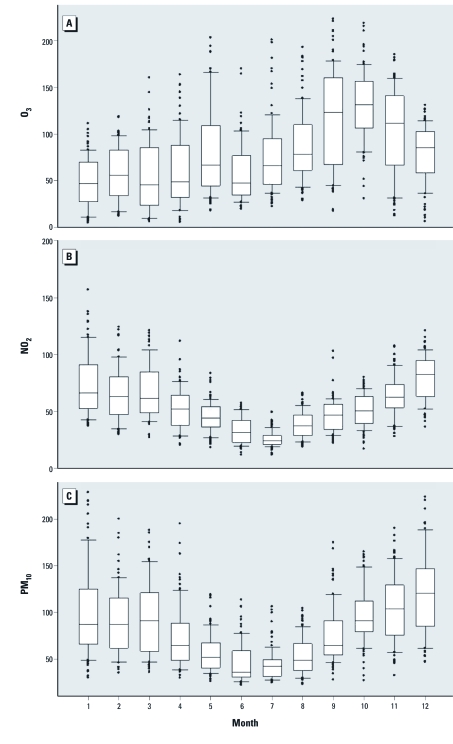
Box plots of monthly O3, NO2, and PM10 concentrations (μg/m3): averaged data from the five monitoring stations, 2006–2008. Boxes indicate the interquartile range (25th to 75th percentile); lines within boxes indicate medians; whiskers represent 5th and 95th percentile values; and circles represent outliers.